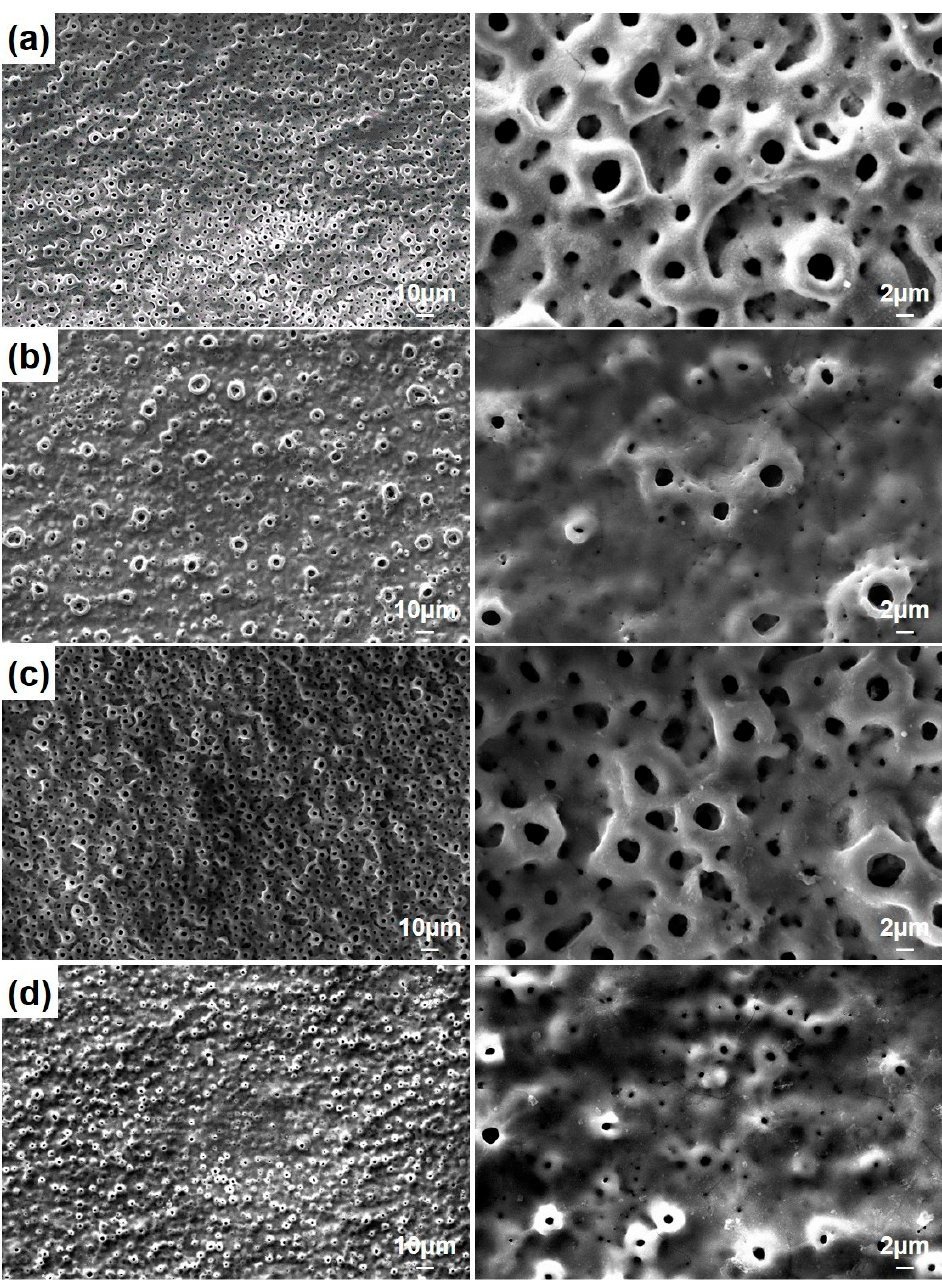
Figure 3. The SEM morphologies of PEO treated coatings with ( a ) free GNS, ( b ) 0.5, ( c ) 1.0, and ( d ) 1.5 wt% GNS additive at different magnifications. ( d ) 1.5 wt% GNS additive at different